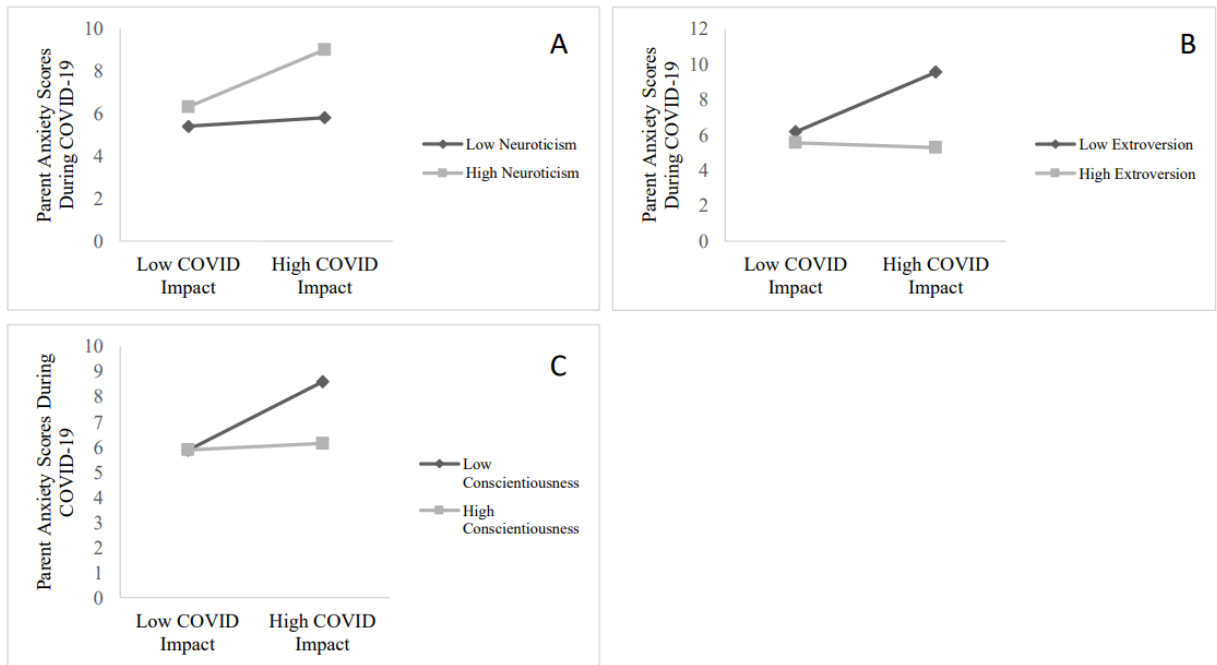
Figure 2. ( A ): Interaction between neuroticism and COVID-19 impact predicting change in parental anxiety symptoms. ( B ): Interaction between extroversion and COVID-19 impact predicting change in parental anxiety symptoms. ( C ): Interaction between conscientiousness and COVID-19 impact predicting change in parental anxiety symptoms. Note: effects of COVID-19-related personal impact on mental health are depicted at ± 1 standard deviation of the moderator.